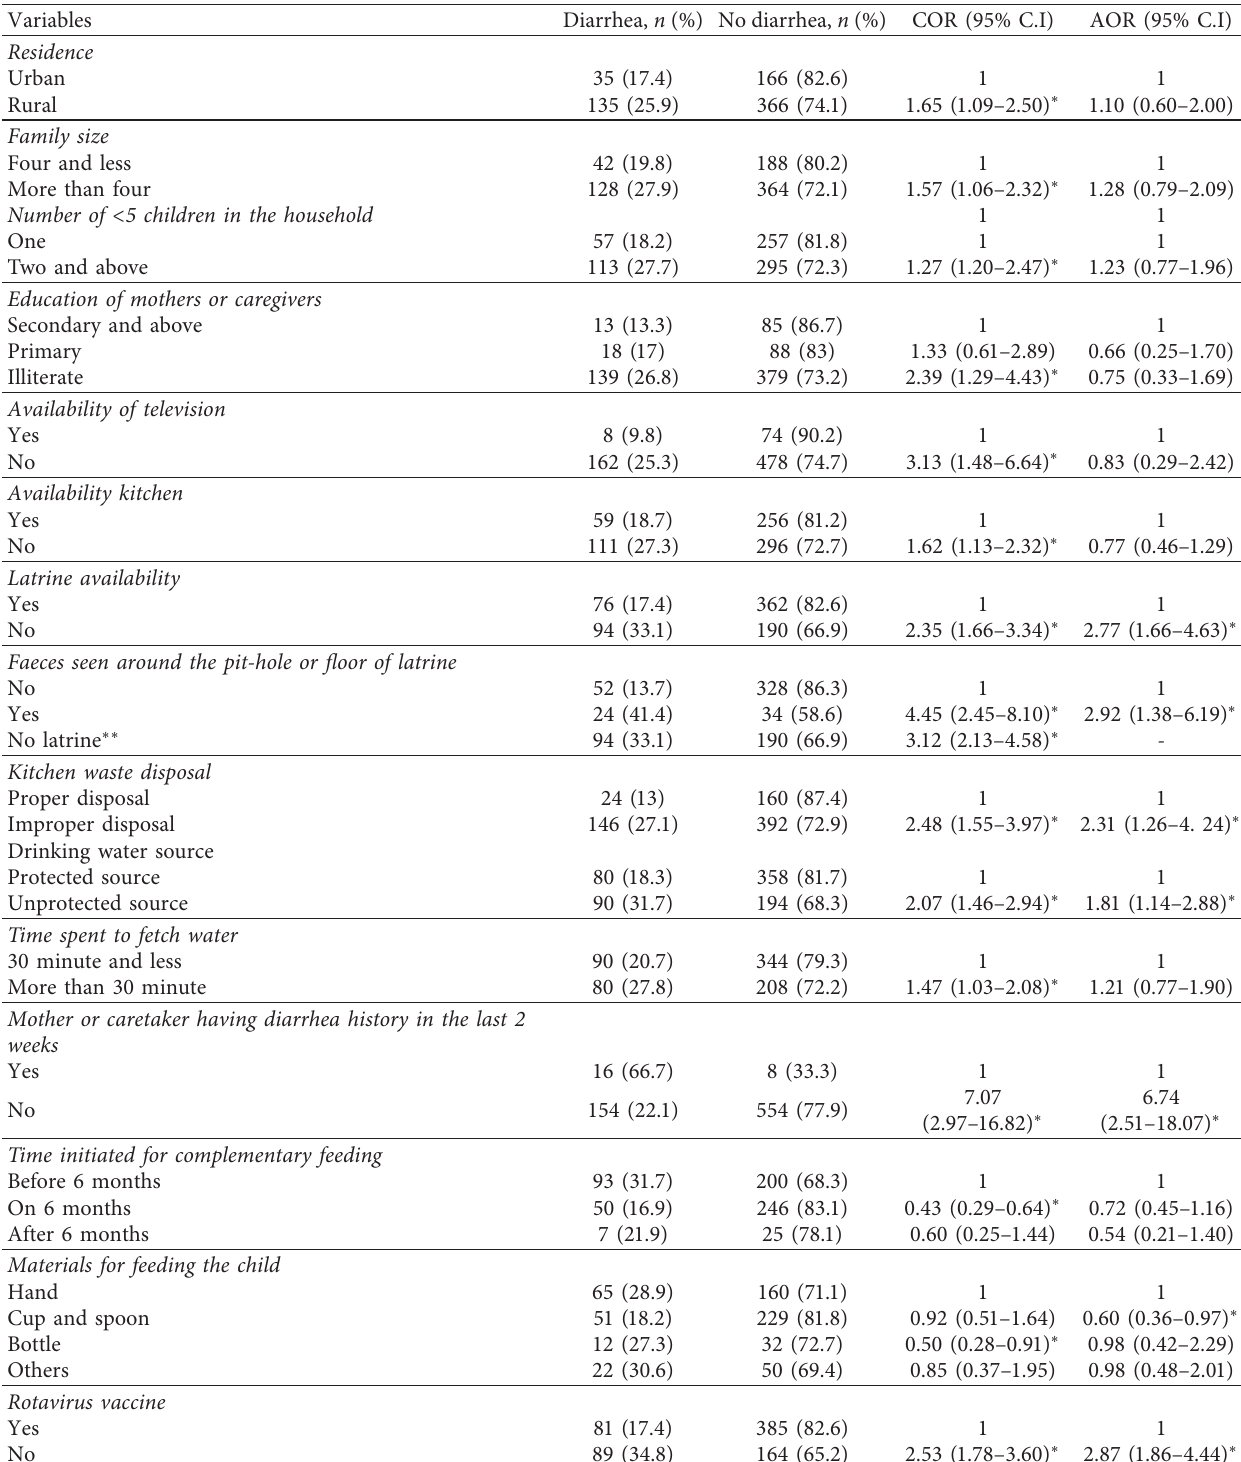
Table 4: Demographic, socioeconomic, and child demographic health determinant of under-five diarrhea in Benna Tsemay District, South Omo Zone, Southern Ethiopia, 01 January to 30 February,